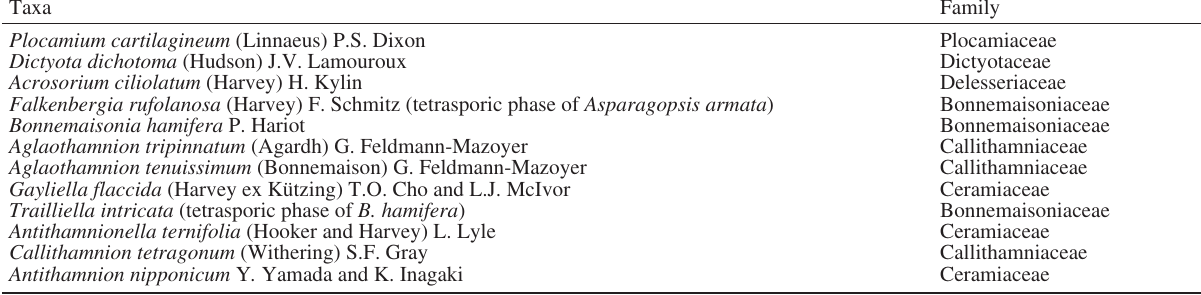
Table 2. – Epiphytic taxa and their families recorded growing on G. corneum during the study period (2008). Taxa are arranged by abundances. Taxa